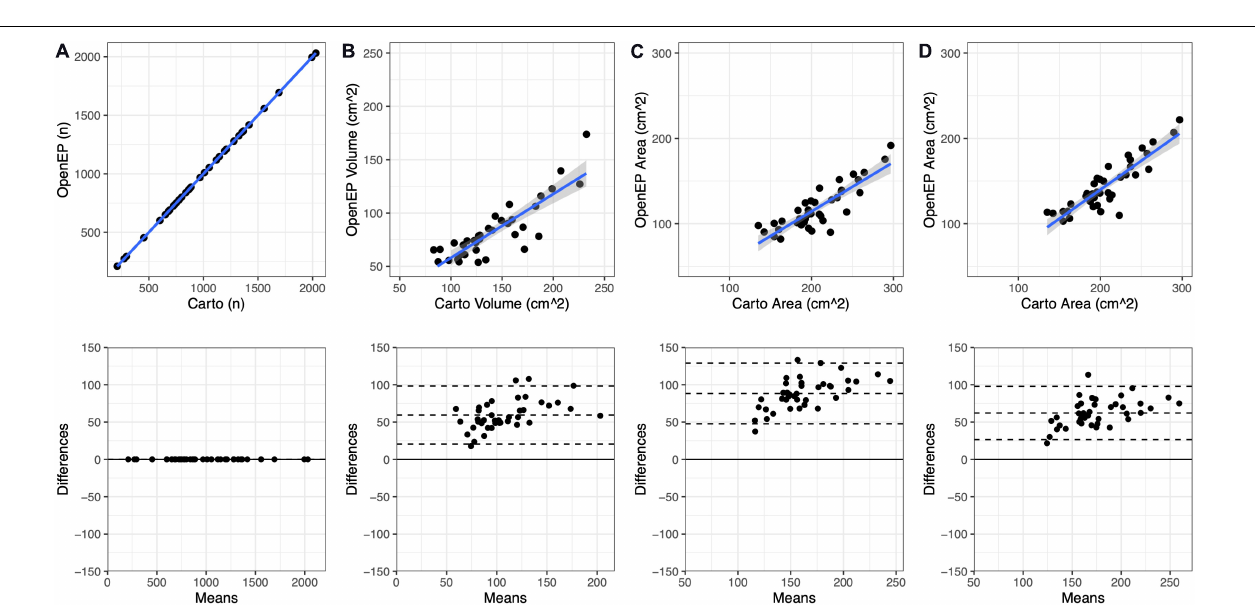
FIGURE 2 | (A) Import time was proportional to the number of mapping points in the clinical dataset. (B) Storage space required for electroanatomic mapping data was three orders of magnitude smaller than the uncompressed Carto data and two orders of magnitude less than the compressed Carto data.